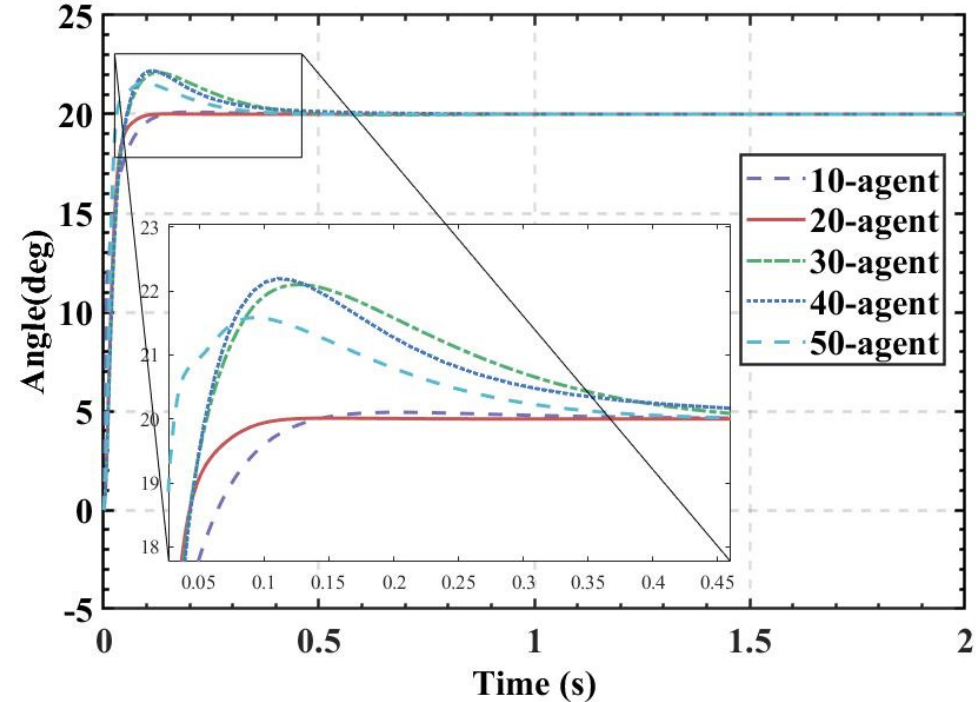
Figure 9. The actual angle of the balancing robot under AOA-PID algorithm.